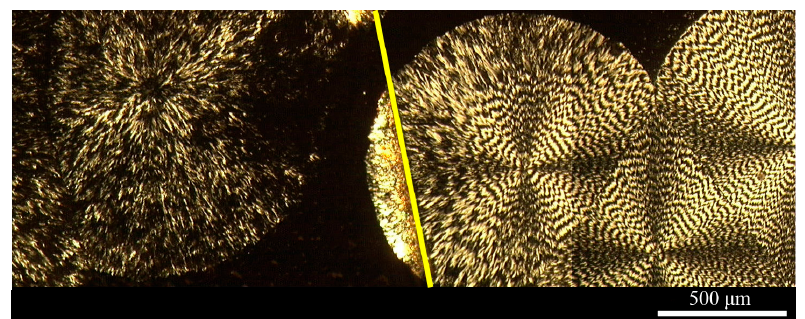
Figure 7. A polarizing optical micrograph of spherulites that formed in a 3 μ m thick film of a PLLA/PEO (50/50) blend crystallized in air at 125 °C for five hours on a glass slide. The right half of the sample was placed under a glass coverslip [42].